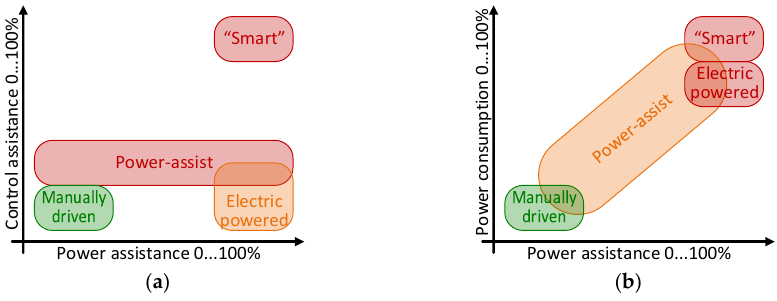
Figure 1. Currently available wheelchairs: ( a ) Cost availability (green—good, yellow—questionable, red—bad), ( b ) power consumption (green—low / no, yellow—average,